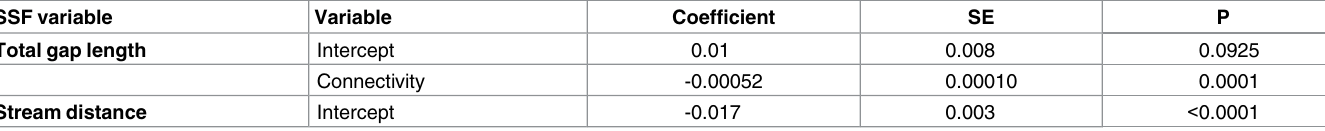
Table 2. Final models predicting the individual-specific coefficients for total gap length and distance to stream from the step selection function (SSF) models. None of the explanatory variables (forest amount, connectivityand sex of the bird) were able to explainthe variabilityobservedin the selection coefficientsfor stream distance, whileonly connectivity affected the selectioncoefficientsfor total gap